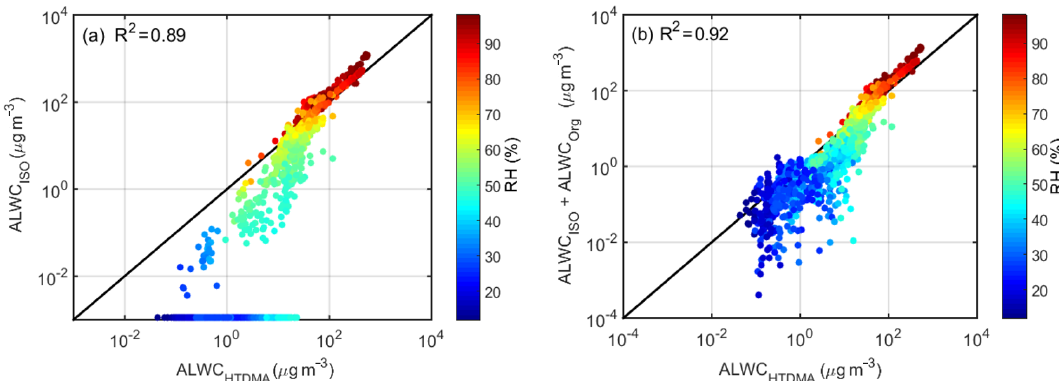
Figure 1. Comparison between ALWC HTDMA and (a) ALWC ISO and (b) the sum of ALWC ISO and ALWC Org . ALWC HTDMA refers to calculated ALWC based on the measured growth factor and PNSDs; ALWC ISO refers to simulated ALWC from the ISORROPIA II model; and ALWC Org refers to the inferred ALWC contributed by organic species. The coefficient of determination R 2 is given in each panel. The color of the dots denotes the ambient RH; the solid line denotes the 1 : 1 line.